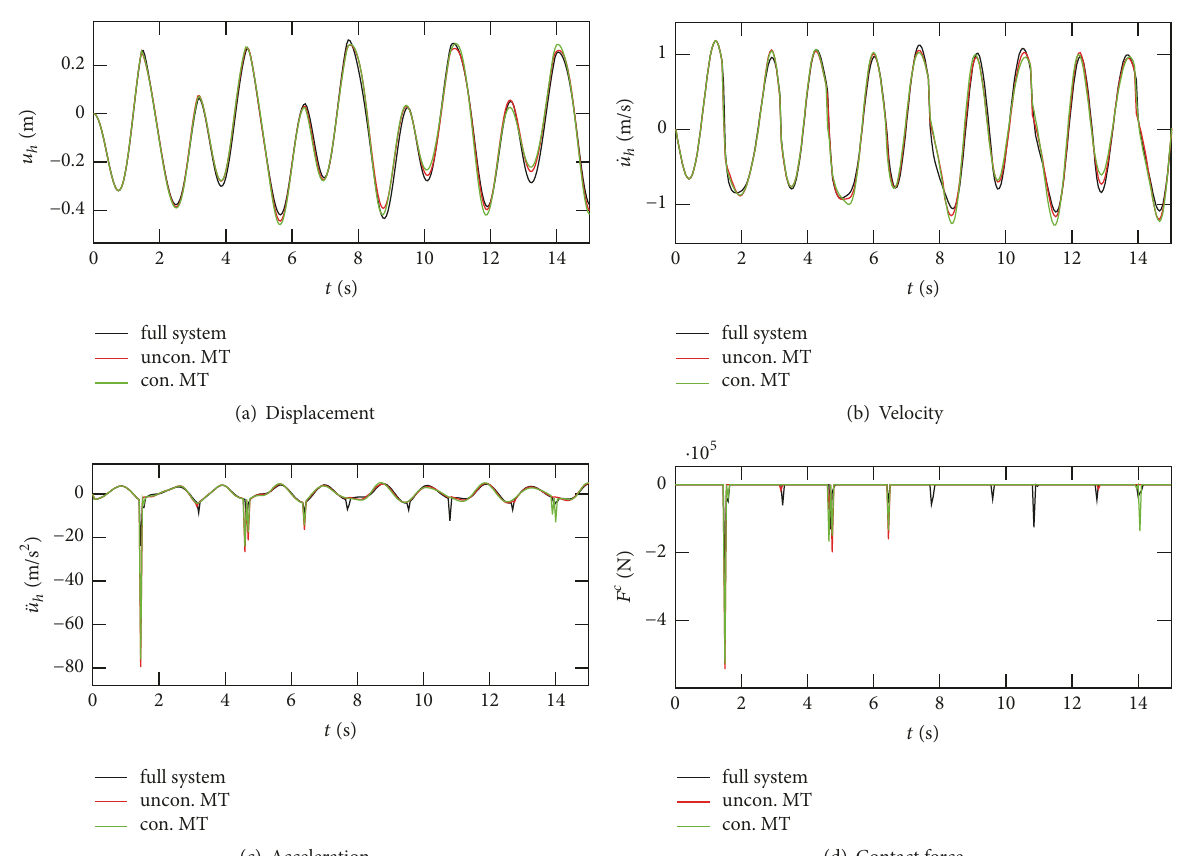
Figure 8: Results for the displacement, the velocity, and the acceleration as well as the contact force with 𝑚 = 15 .